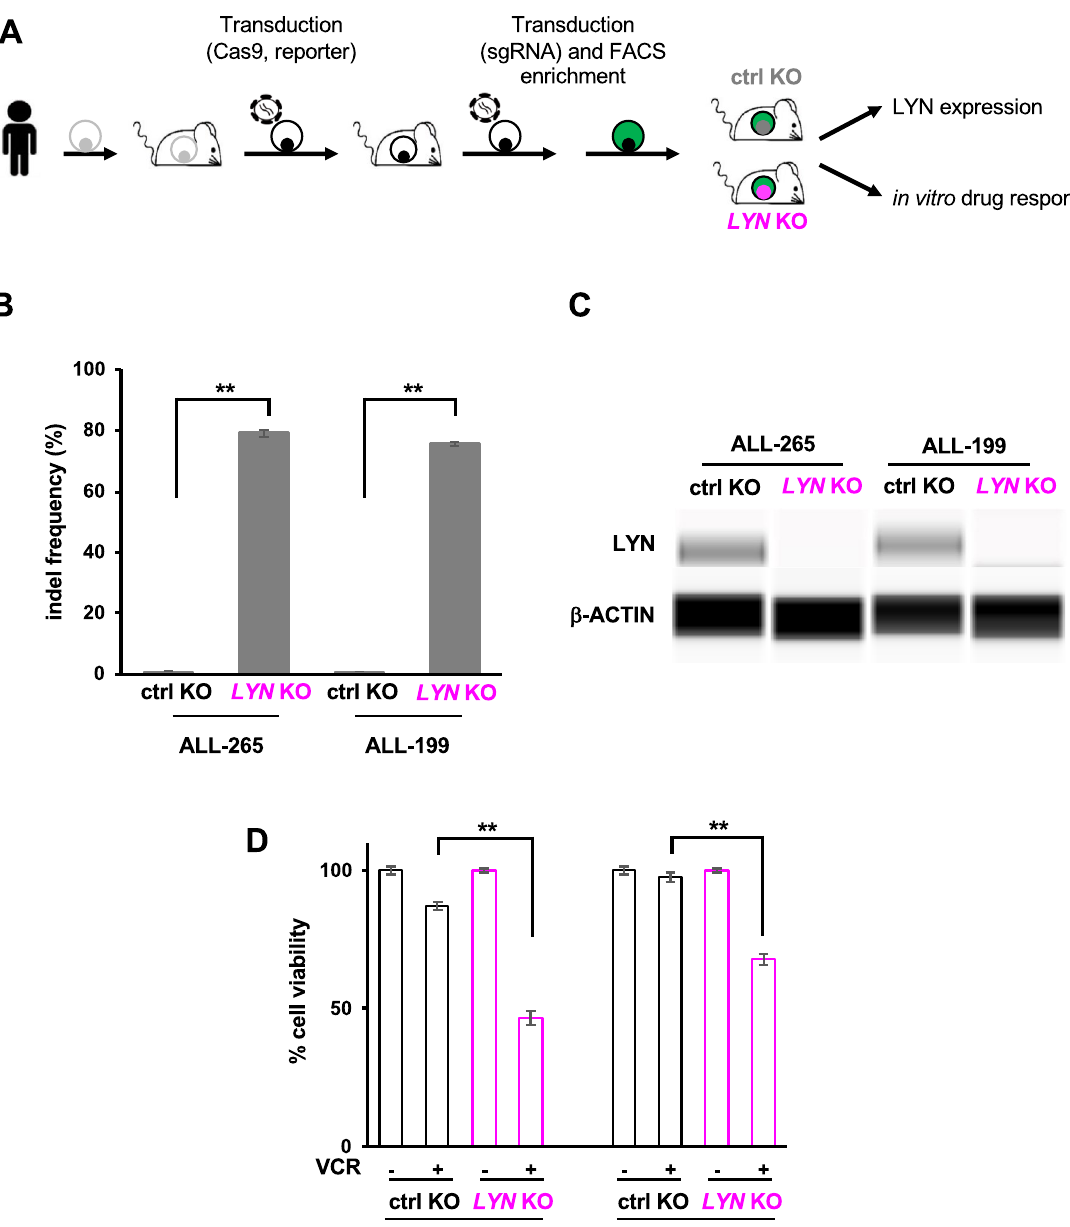
Figure 2. KO of LYN sensitizes patient-derived xenograft (PDX) cells towards treatment with Vincristine. ( A ) Experimental procedure; Primary pediatric B-ALL cells were amplified in NSG mice, resulting PDX cells were isolated and lentivirally transduced with Cas9 and the reporter expression vector, each followed by one round of amplification in mice. Marker-positive cells, mTaqBFP for Cas9, iRFP for the reporter construct (see Figure S2B for constructs) were transduced with either GLuc control or LYN sgRNA; reporter GFP-positive PDX cells were injected into NSG mice to generate GLuc ctrl (black) and LYN KO (pink) PDX derivatives. Mice were sacrificed upon advanced leukemia and KO cells subjected to LYN protein expression analysis and in vitro drug treatment. ( B ) Enrichment of indel frequency at the LYN locus in PDX cells; Digital droplet PCR (ddPCR) was performed to determine percentage of LYN edited alleles in cells with control KO versus LYN KO from PDX ALL-265 and ALL-199. Mean ± SD of 3 independent experiments is shown; ** p < 0.01. ( C ) LYN protein expression is reduced in reporter positive PDX cells; Automated calculated pictures of capillary immunoassay of LYN protein expression in cells sorted as described in ( A ). β-ACTIN served as a loading control; one representative calculated picture out of 3 independent experiments is shown. ( D ) LYN knockout sensitizes PDX cells to vincristine (VCR) treatment; PDX ALL-265 and ALL-199 GLuc KO (ctrl) or LYN KO cells were treated with or without 1 ng/ ml VCR in vitro for 2 days. Cell viability was determined by flow cytometry. Mean ± SD of 3 independent experiments is shown. ** p <